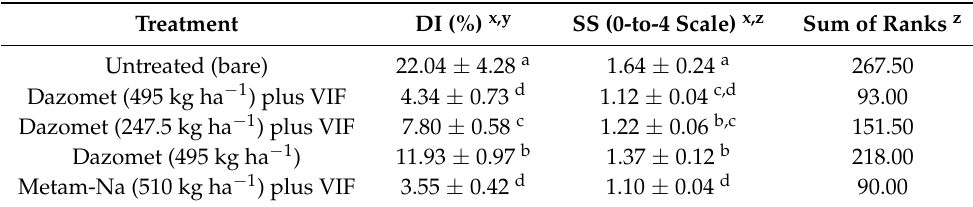
Table 4. Compared performances of fumigation treatments in reducing natural infections (DI = disease incidence; SS = severity symptoms) caused by Verticillium dahliae on Chrysanthemum × morifolium cv “Anastasia” during 2012 and 2013 crop seasons.